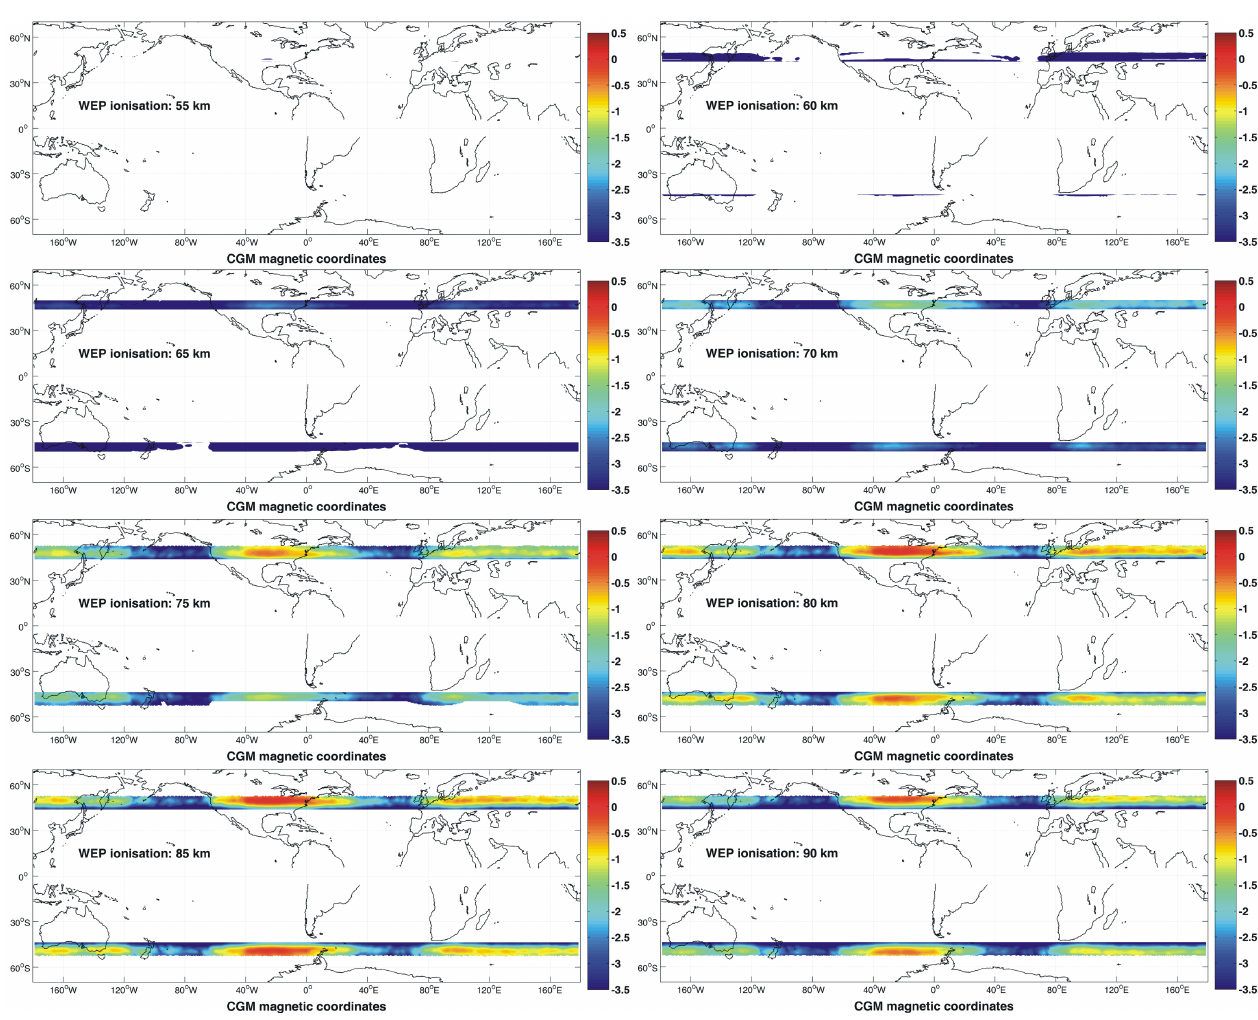
Fig. 2. Maps showing the mean ionisation rate due to WEP into the atmosphere, based on the energy deposition shown in Fig. 1. Ionisation rates are shown with units log 10 (electronscm − 3 s − 1 ) . Only those locations and altitudes with non-zero energy fluxes are included in the